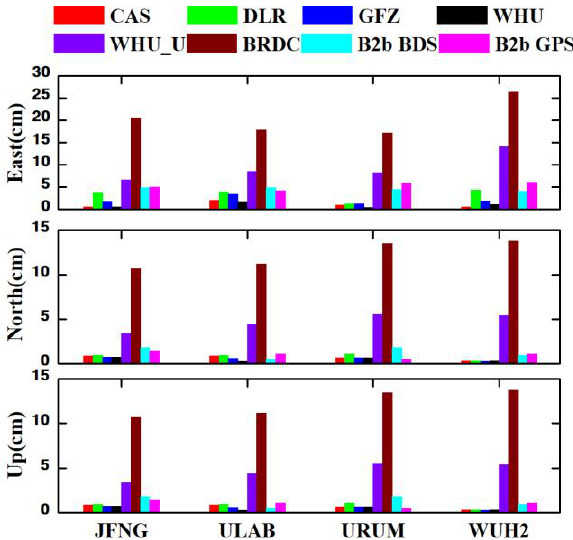
Figure 7. The average accuracy of the four-day IF static PPP solution.